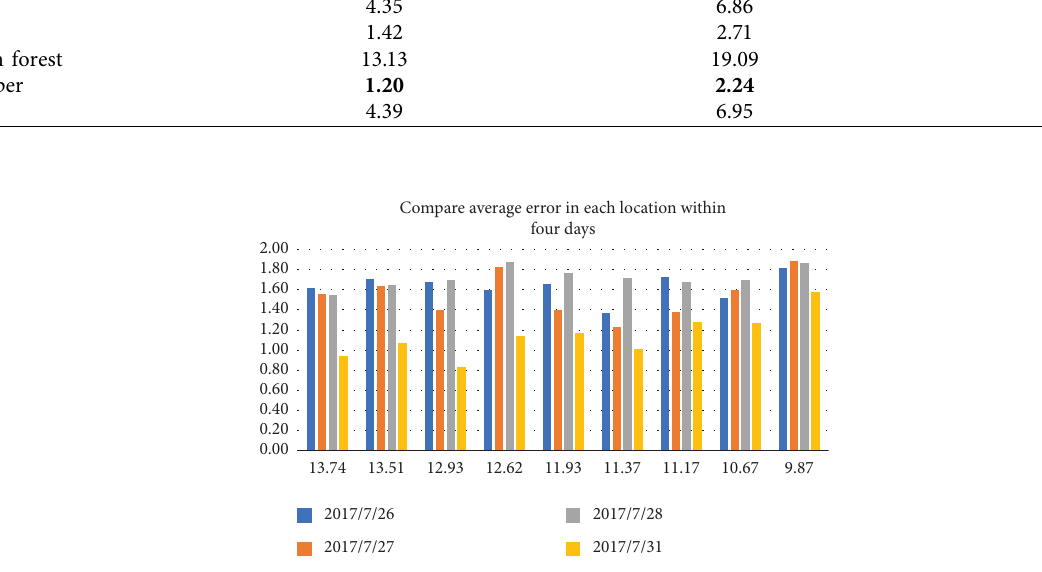
Figure 10: Comparison of average error in each location within four days in all day.